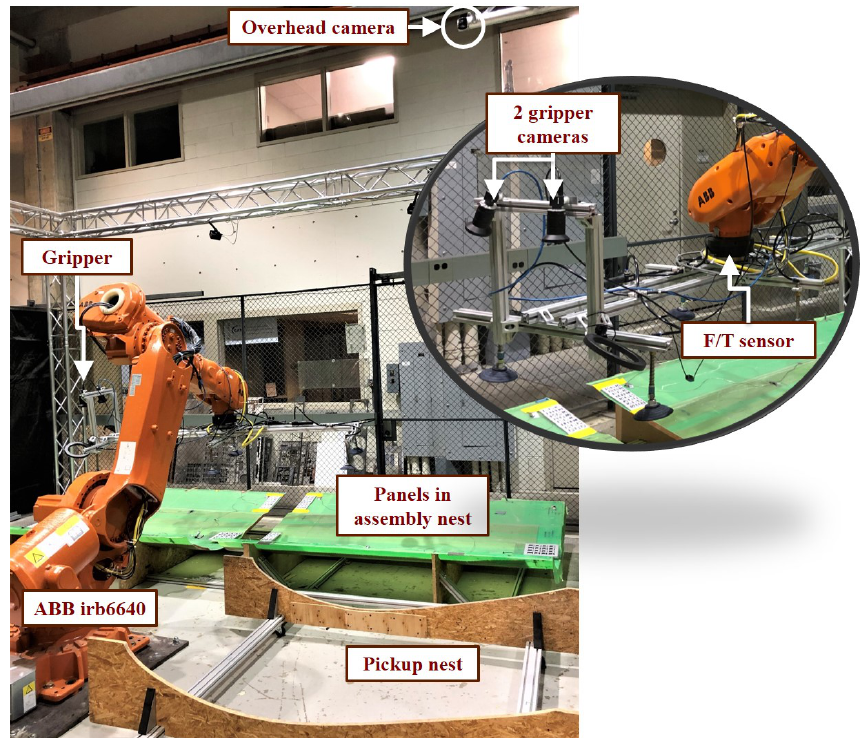
Figure 1. The experimental testbed approximates part of the actual factory manufacturing scenario. A robot picks up an incoming panel from the pick-up nest and transports it to the placement nest where it needs to be aligned to a reference frame or with another